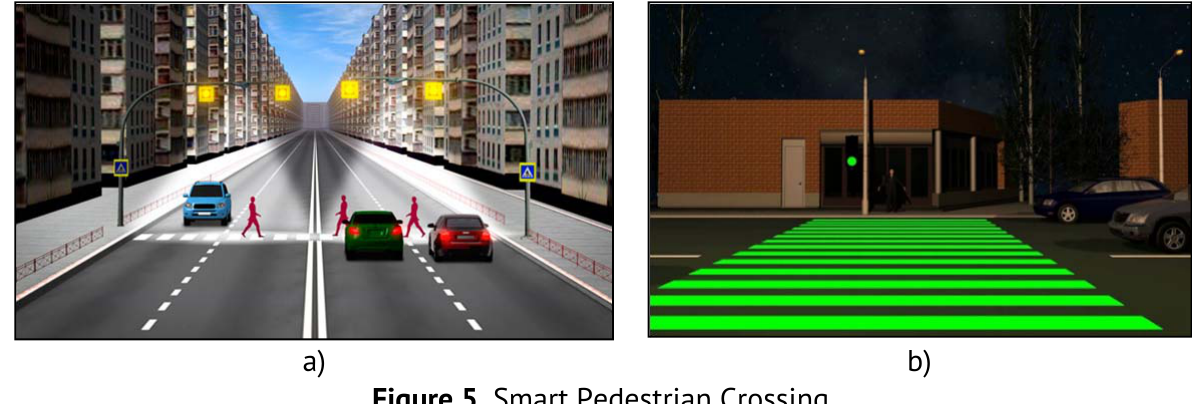
Figure 5. Smart Pedestrian